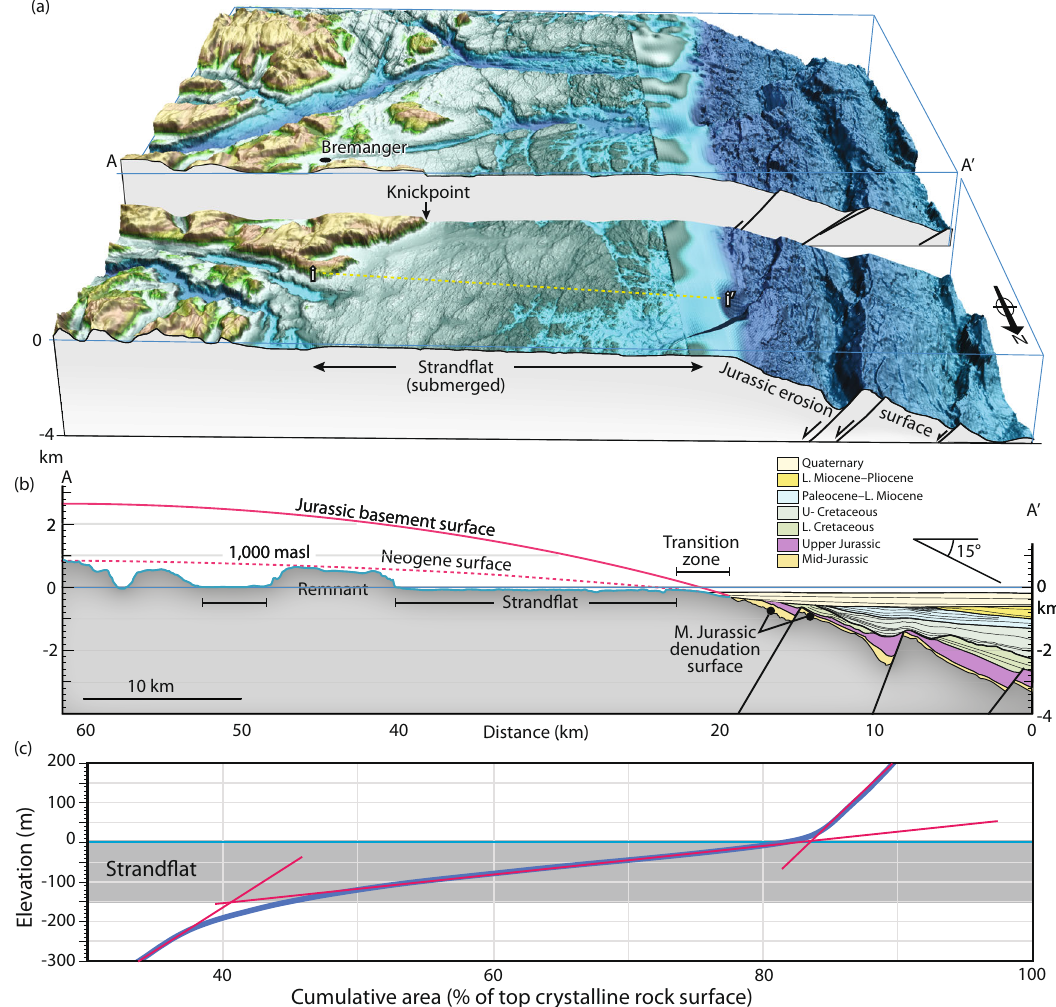
Fig. 3 The strand fl at in the northern part of the study area. a 3D model of the submerged strand fl at in the Stad-Måløy Slope area, viewed from the north (2x vertical exaggeration, see Fig. 5 for location). Mesozoic sediments west of the strand fl at have been removed. The subhorizontal strand fl at is very well developed in this area, and the transition to the ca. 15° W-dipping bedrock surface to the west clearly de fi nes its offshore limit (note that Mesozoic and younger sediments have been stripped off). Onshore the strand fl at is separated from a more elevated land surface with an abrupt break in slope. Color scheme as for Fig. 2a. b shows the central section of a with its sedimentary offshore cover. c is the hypsometric curve for the area covered by a , allowing the main strand fl at interval to be de fi ned for the interval − 150 m to near sea